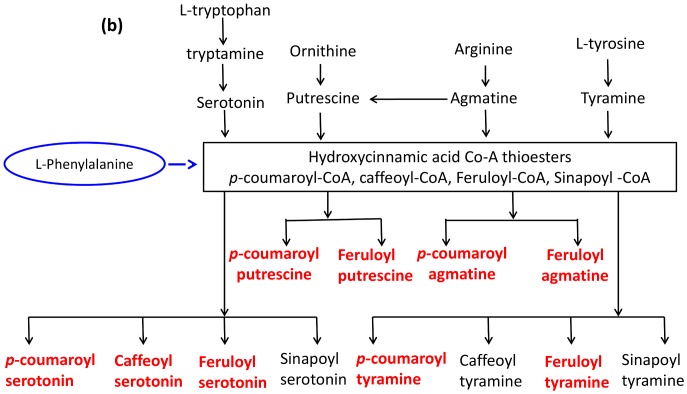

F. graminearum induced shunt phenylpropanoid pathway showing the synthesis of hydroxycinnamic acid amides following the conjugation of amides synthesized from amino acids with hydroxycinnamic acid CoA thioesters (Compounds in bold/red letters are detected in the study).Pathway adapted from http://pmn.plantcyc.org/ARA/NEW-IMAGE?type=PATHWAY&object=PWY-5473, 5474, 40.